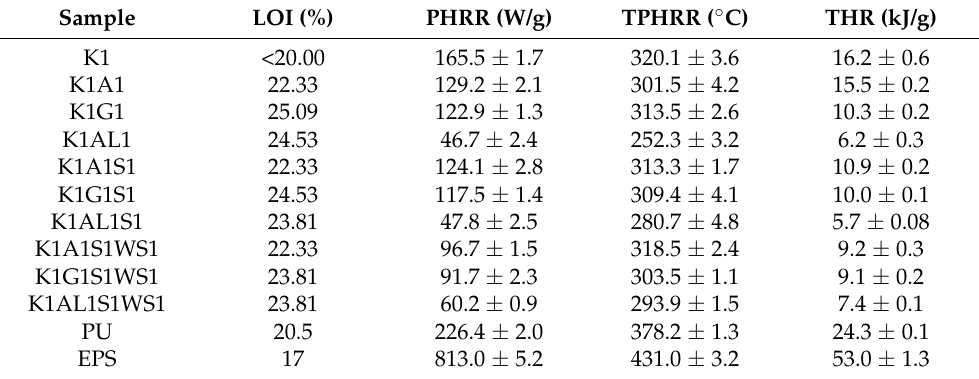
Table 2. The flame retardancy of samples from limiting oxygen index (LOI) and microscale combus- tion calorimeter (MCC)